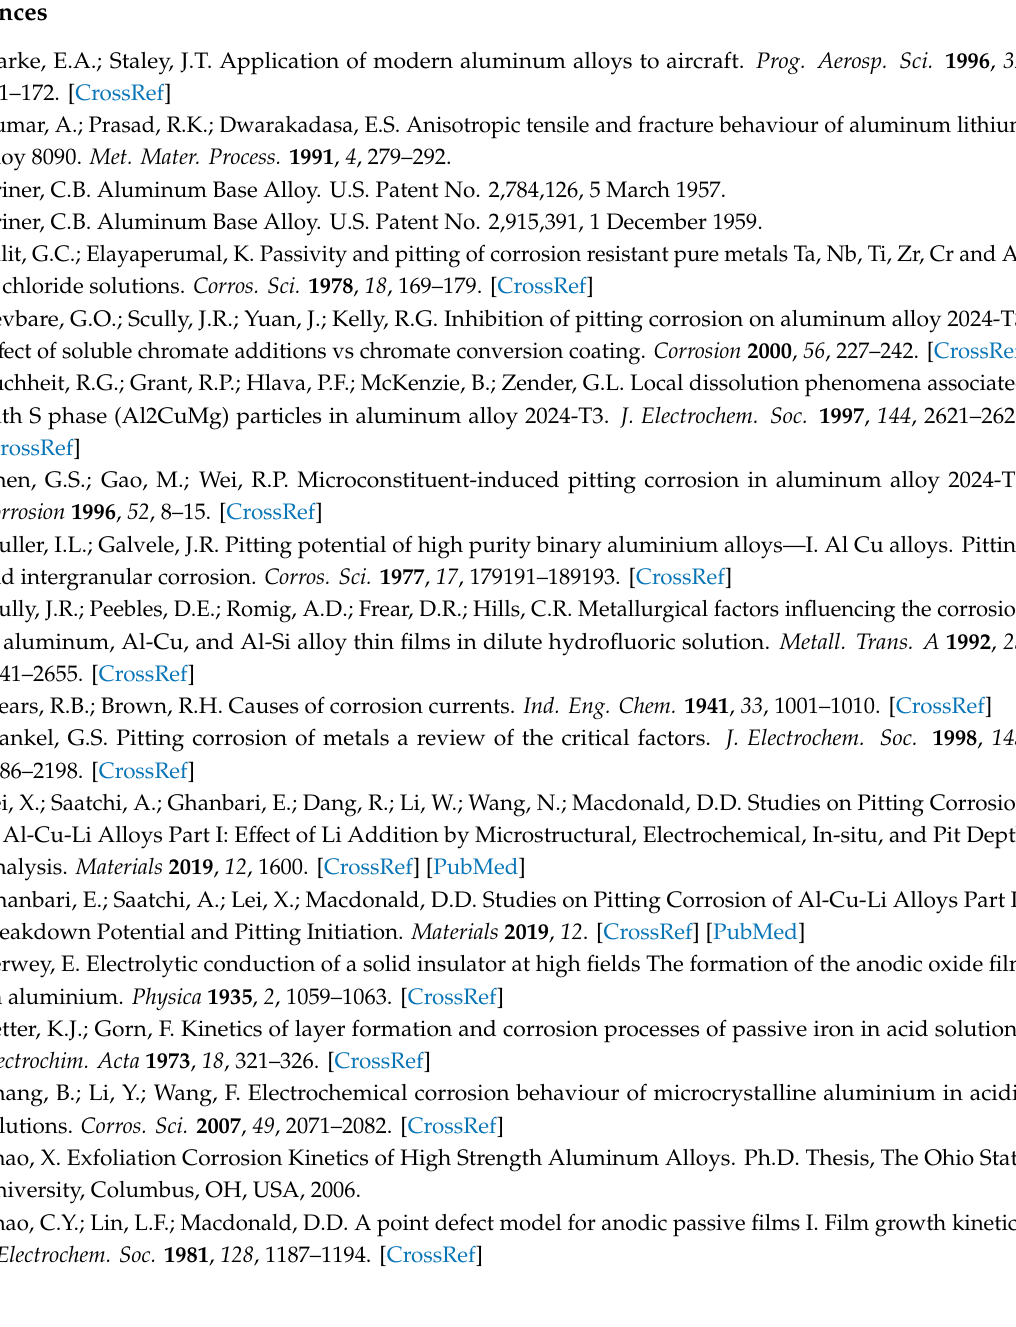
Table S1: Fitting parameters of passive layer formation obtained by optimization of the EIS results based on the